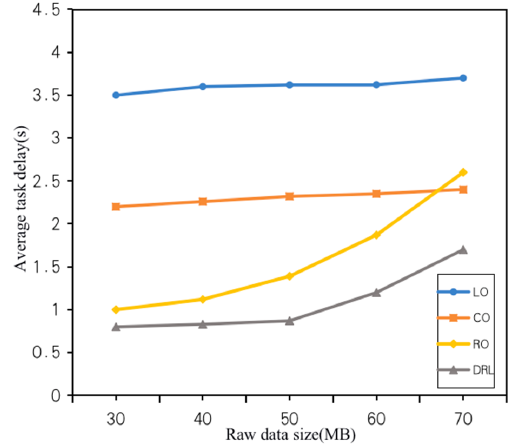
Figure 3. Relationship between delay and data size.